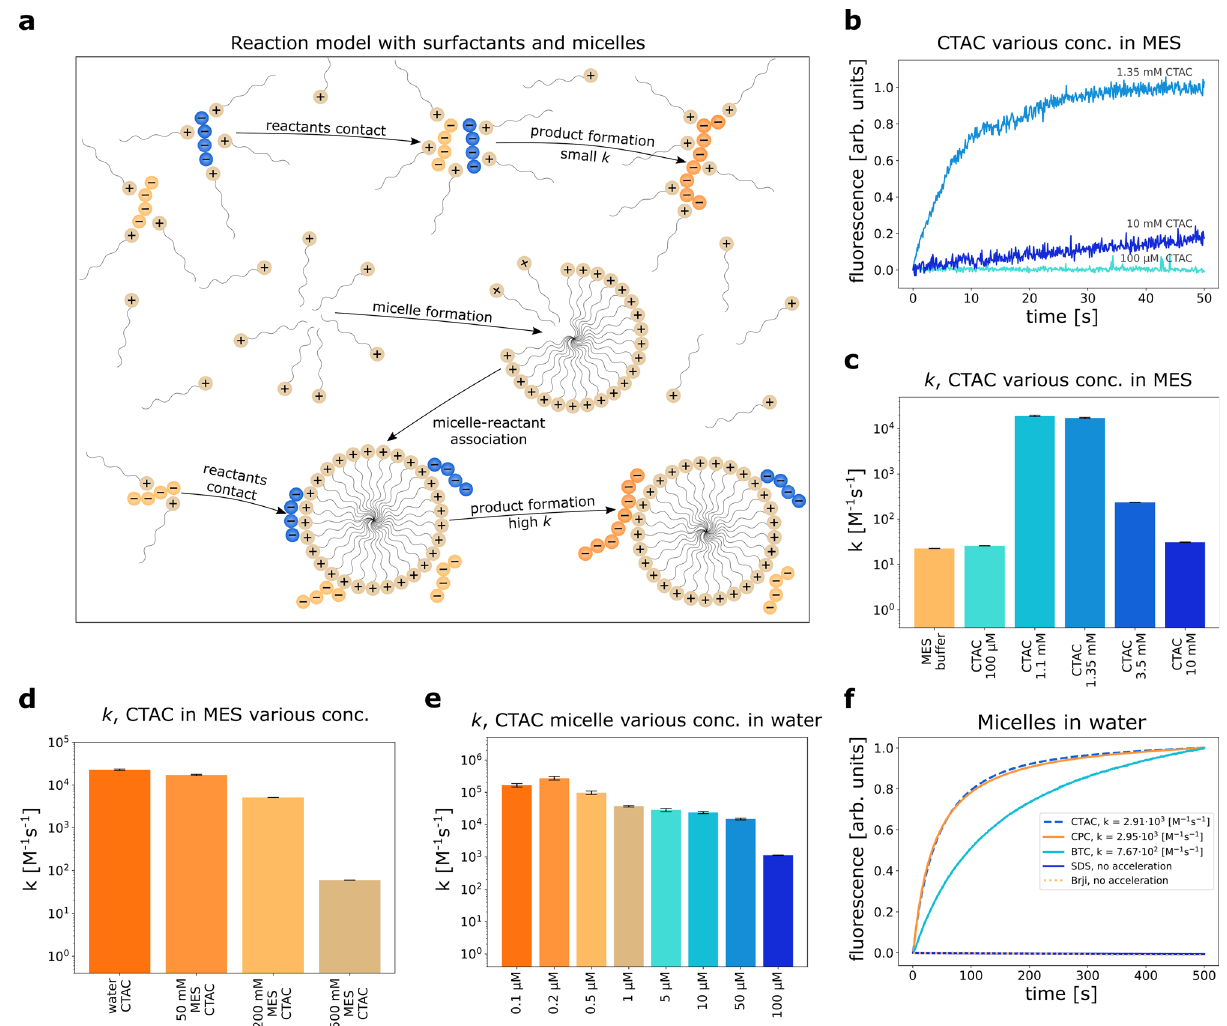
Fig. 4 | Reaction in the presence of micelles. a Reaction model with surfactants; product formation can be accelerated either by free surfactants or micelles with different speeds. b Reaction in 50 mM MES catalyzed with CTAC of different con- centrations(aboveandbelowCMC,CMC=0.7mM),and c its k values. d k valuesfor product formation in constact concentration of CTAC micelles (8 μ M) and various concentrations of MES pH 6.1. e k values for CoA/CoA-M reaction versus different CTACmicelleconcentrationinwater(CMC=1.06mM)atconstantconcentrationof